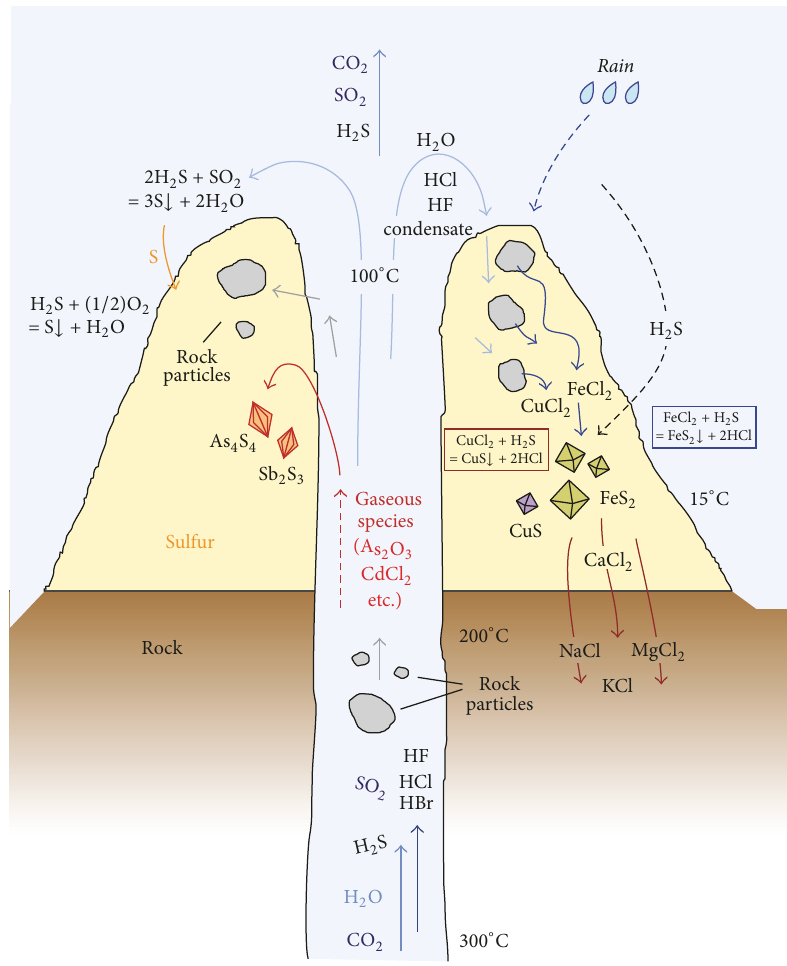
Figure 10: Chemical processes in low-temperature sulfur fumaroles. Fumarolic gases (mainly H 2 O, CO 2 , SO 2 , H 2 S, and HCl) carry volatile metal species and some amount of rock aerosol. At the fumarole vent, the temperature abruptly decreases and volatile species condense, forming solid phases and acid condensate that is enriched in HCl, while H 2 S mainly escapes. Sulfur is precipitated due to the reaction between H 2 S and SO 2 and the partial oxidation of H 2 S. Hot acid condensate can attack rock particles, extracting metals. Then, the condensate cools to ambient temperature and the chlorides of metals (e.g., CuCl 2 , FeCl 2 ) from the acid solution react with H 2 S to form insoluble sulfides. Petrogenic elements do not form sulfides, and their chlorides are washed away from incrustations by atmospheric